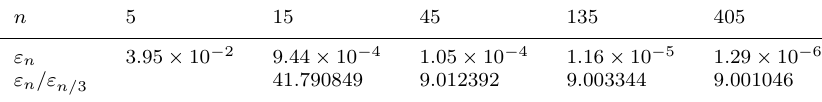
Table 4. Numerical results for f ( x ) = x 3 , x ∈ [ − 1 , 1] , uniform mesh, n even. n 8 ε n ε n /ε n/ 2